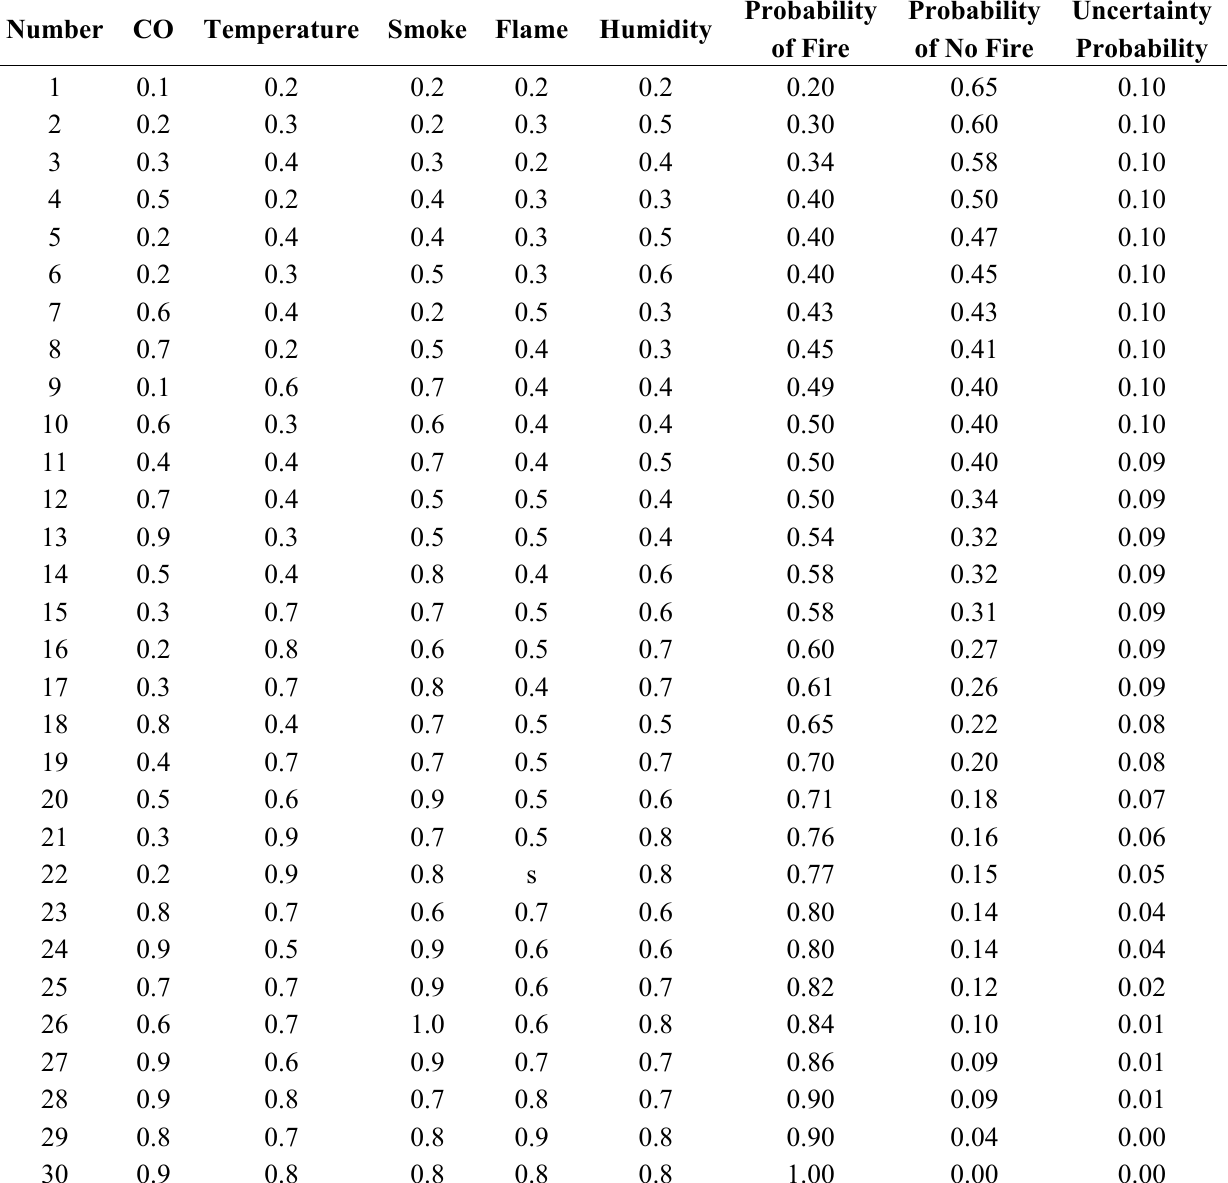
Table 6. Improved expert database for